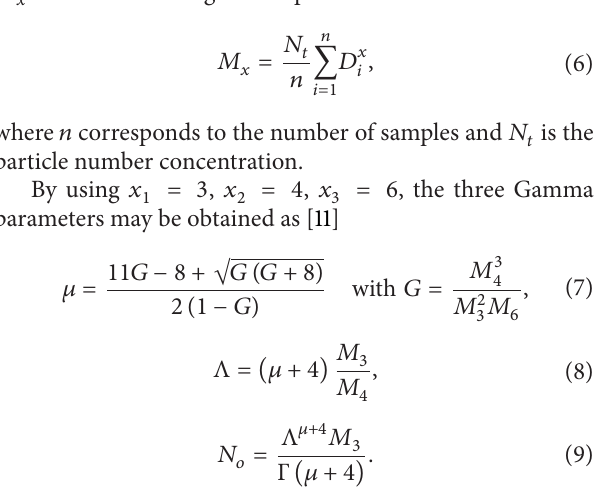
be able to reproduce the statistical properties of local DSD parameters in order to assess the same parameters when they are inferred from remote sensing instruments, such as ground weather radar or space-borne radar. This subsection presents the results regarding the statistical properties of both model well as the relationships between these